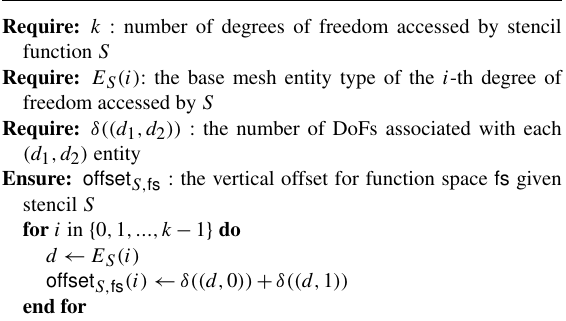
Algorithm 2 Computation of vertical offsets Algorithm 3 Iteration of a stencil function over an